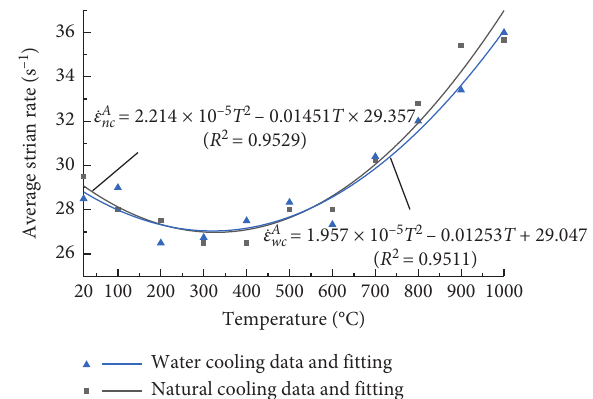
Figure 11: Average strain rate of high temperature sandstone after two cooling